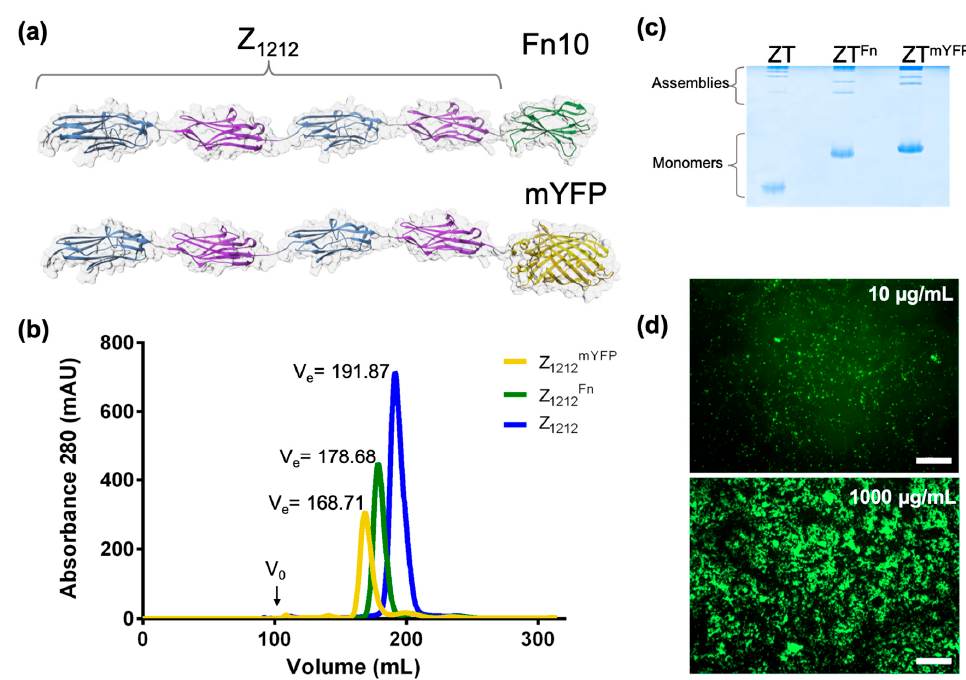
Figure 4. ZT functionalization through genetic fusion of proteins. ( a ) Molecular models of functional chimeric variants of Z 1212 tandems; ( b ) size exclusion chromatograms of unmodified and chimeric tandems performed on a Superdex S200 26/60 column (GE Healthcare) that demonstrate the monodispersity of the samples (molecular mass: Z 1212 = 41.76 kDa; Z 1212 Fn = 52.27 kDa; and Z 1212 mYFP = 68.78 kDa); ( c ) native-PAGE of Z-tandems and Tel mixtures 24 h post-assembly; ( d ) fluorescence images of polymeric ZT mYFP adhered onto a polystyrene surface (96 well-plate, COSTAR, Corning) acquired using an Axi Zeiss Zoom V16 fluorescence microscope (Scale bar = 100 µm).